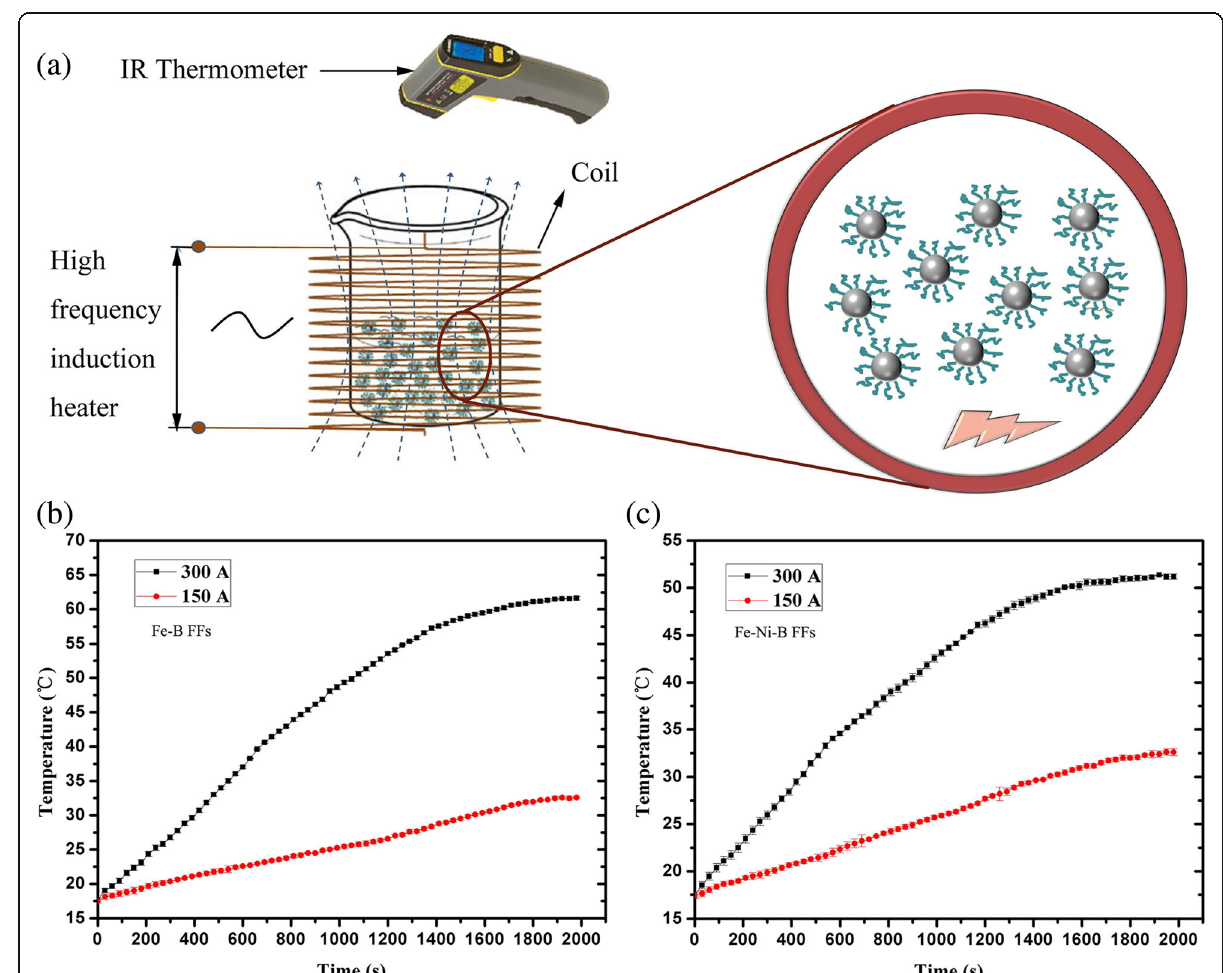
Fig. 8 The schematic map of experimental setup for the magnetic heating experiment ( a ), the heating curves of the amorphous Fe-B FF ( b ), and the heating curves of the amorphous Fe-Ni-B FF( c